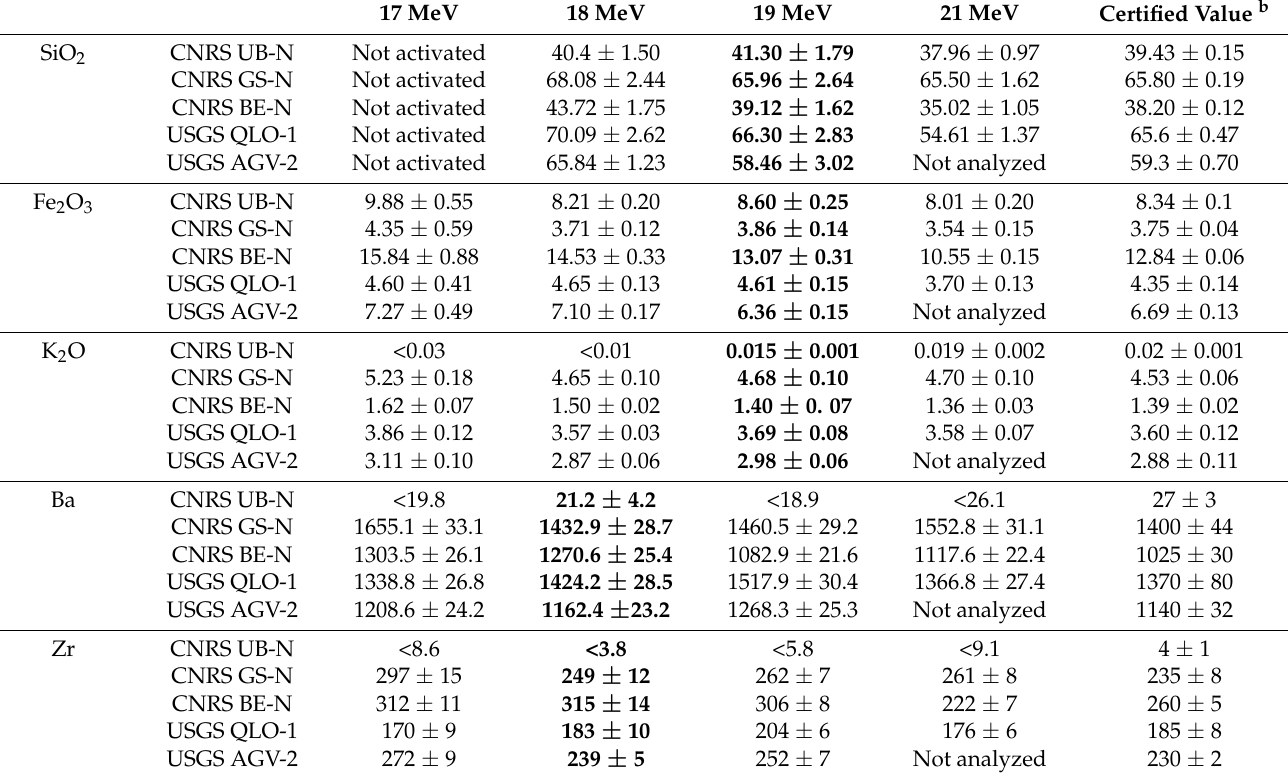
Table 3. Contents of Si, Fe, and K (recalculated to oxides, wt.% ± U a ) and Ba and Zr ( µ g · g − 1 ) determined by IPAA